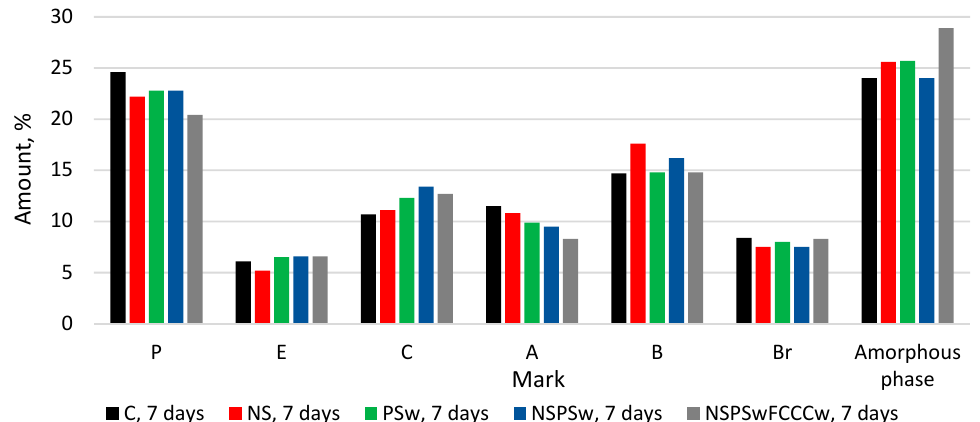
Figure 2. The comparison of the amount of minerals and amorphous phase at 7 days.